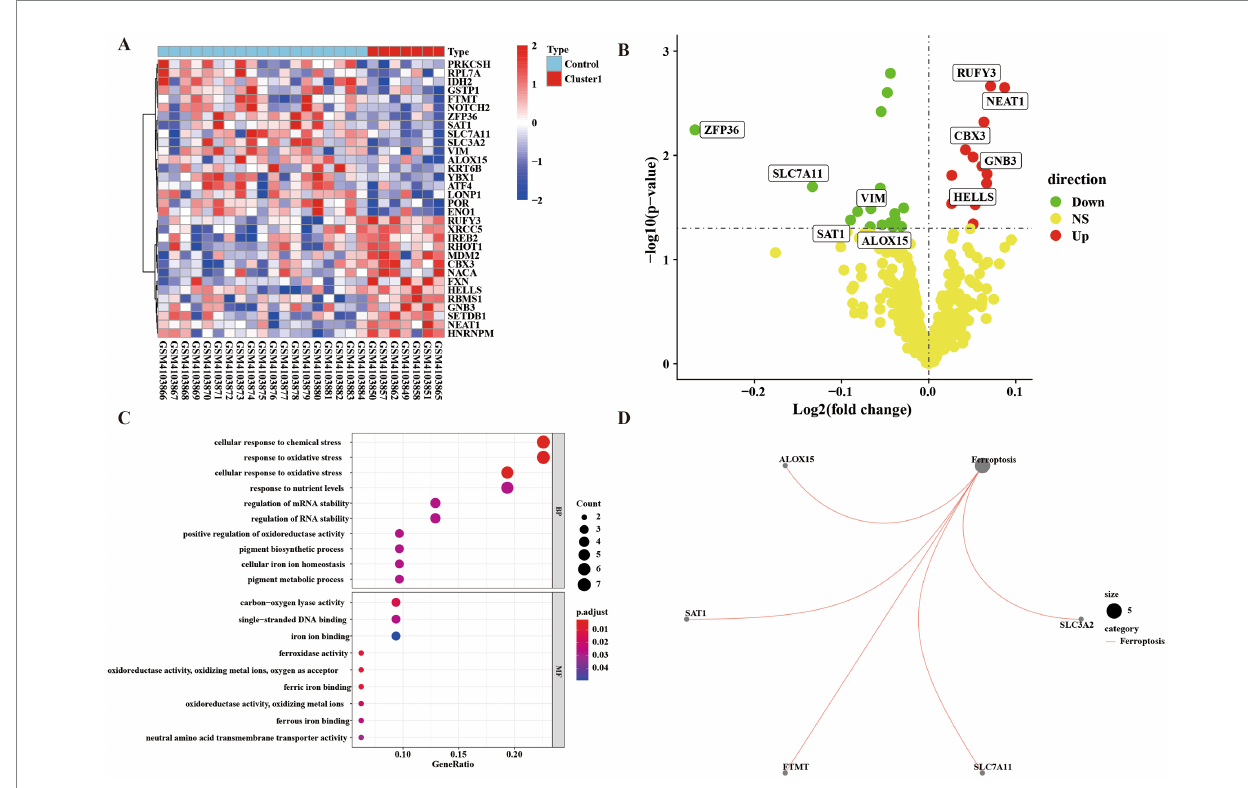
FIGURE 3 Gene difference enrichment analysis was performed between Cluster 1 group and control group. (A) Heatmap of differential gene enrichment analysis between Cluster 1 group and control group. (B) Volcanic map of difference analysis between Cluster 1 group and control group. (C) Bubble plot of GO analysis between normal group and Cluster 1 group. The size of each circle indicates the gene count. The color of circles represents different −log10 (values). (D) KEGG pathway diagram of enrichment analysis between normal group and Cluster 1 group.